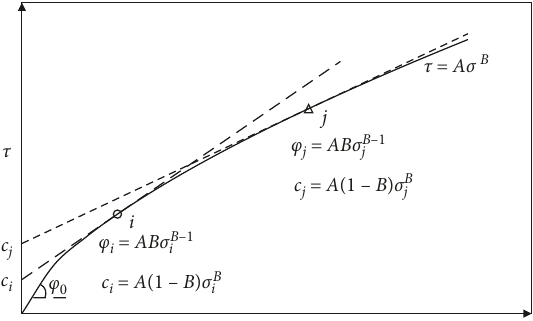
Figure 5: Calculation of interlocking strength of cohesionless soils.